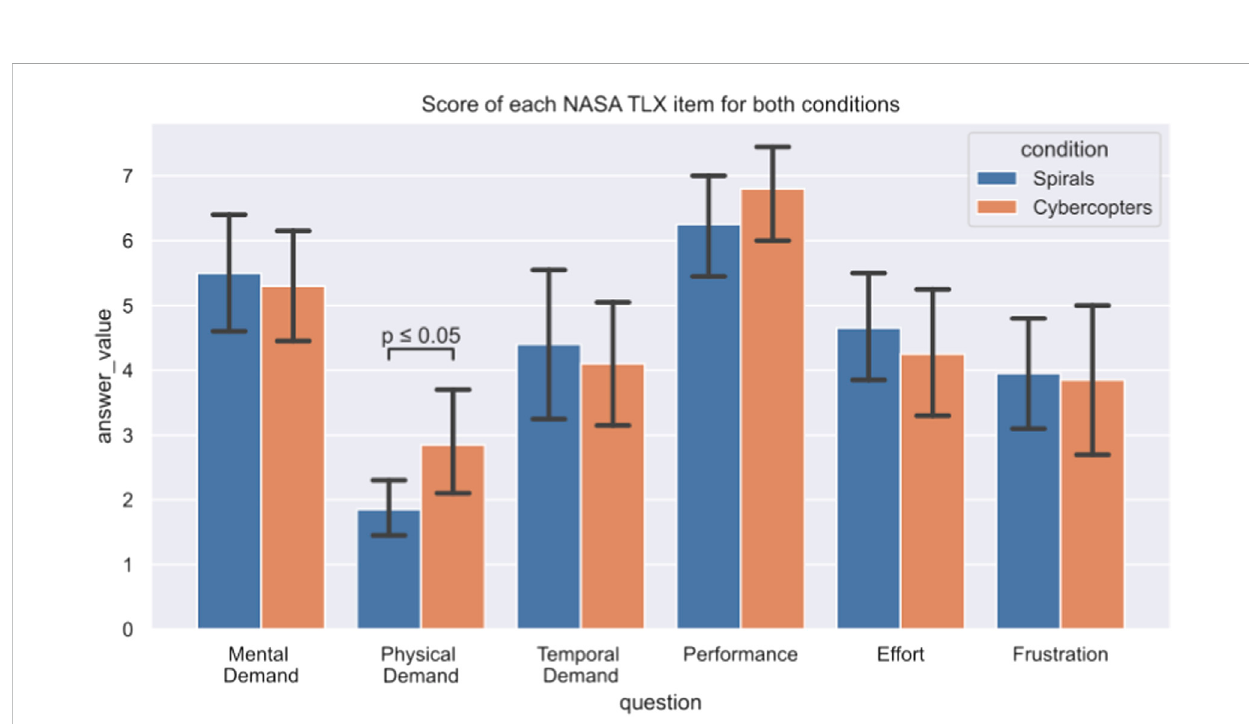
FIGURE 10 Detailed answers to the NASA-TLX for both interfaces. The only signi fi cant difference between them was the second question, asking about the physical demands of the task.